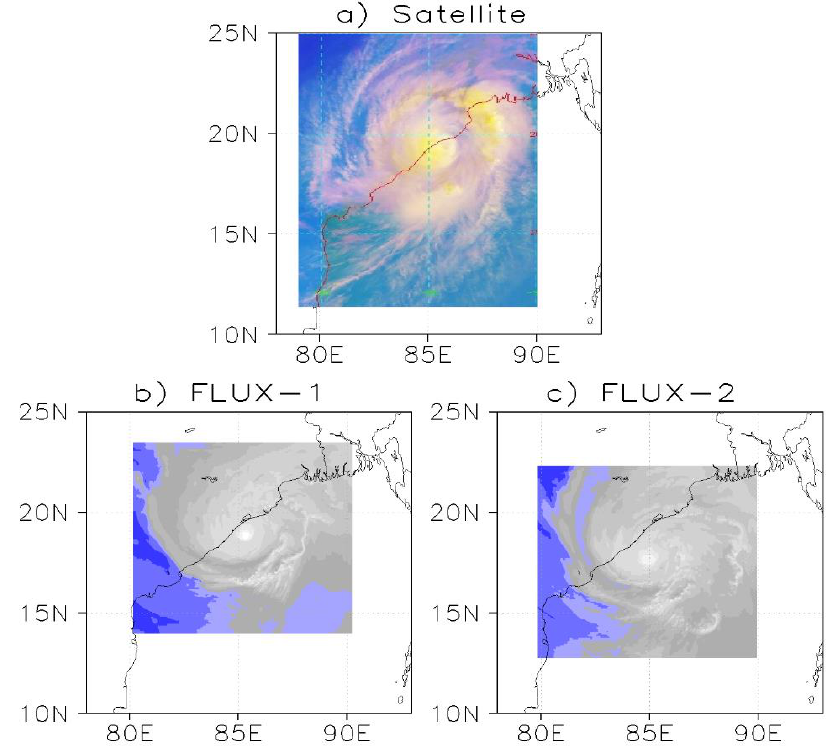
Figure 9. Structure of water vapor content at 0000 UTC on 3 May 2019 obtained from ( a ) the Satellite observation, ( b ) the FLUX-1 experiment, and ( c ) the FLUX-2 experiment. Figure 9a was adopted from the Regional and Mesoscale Meteorology Branch (https://rammb-data.cira.colostate.edu/tc_realtime/storm.asp?storm_identifier=io012019; accessed on 20 February 2020). This figure is used to see the structures only to visualize if the structure is correctly reduced in the model